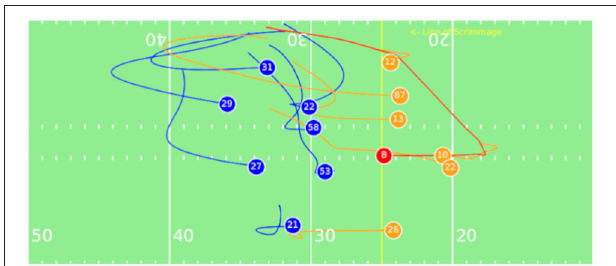
FIGURE 1 | Motivational Play: Eli Manning (10) throws a pass short right to Cody Latimer (12) for 8 yards before stopped by a tackle. The the trajectories of offensive teams are displayed in orange, the trajectories of defensive teams are displayed in blue, and the ball trajectory in red. The line of scrimmage is labeled and displayed in